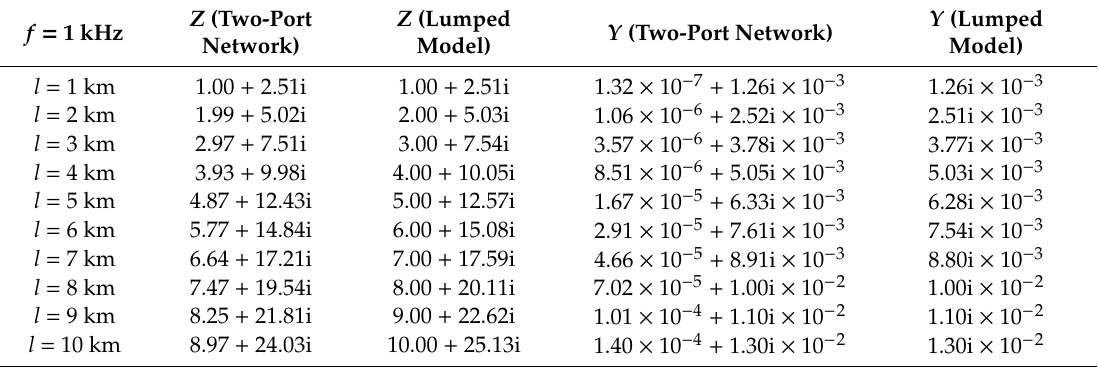
Table 2. The comparison of the two-port network and the lumped parameter model under different cable segment lengths.